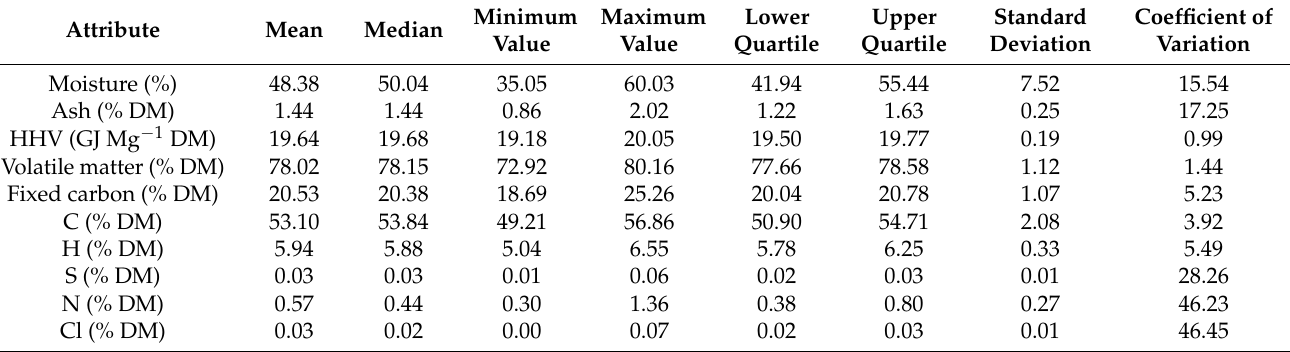
Table 5. Selected statistical analysis indicators for the SRWC characteristics under study.